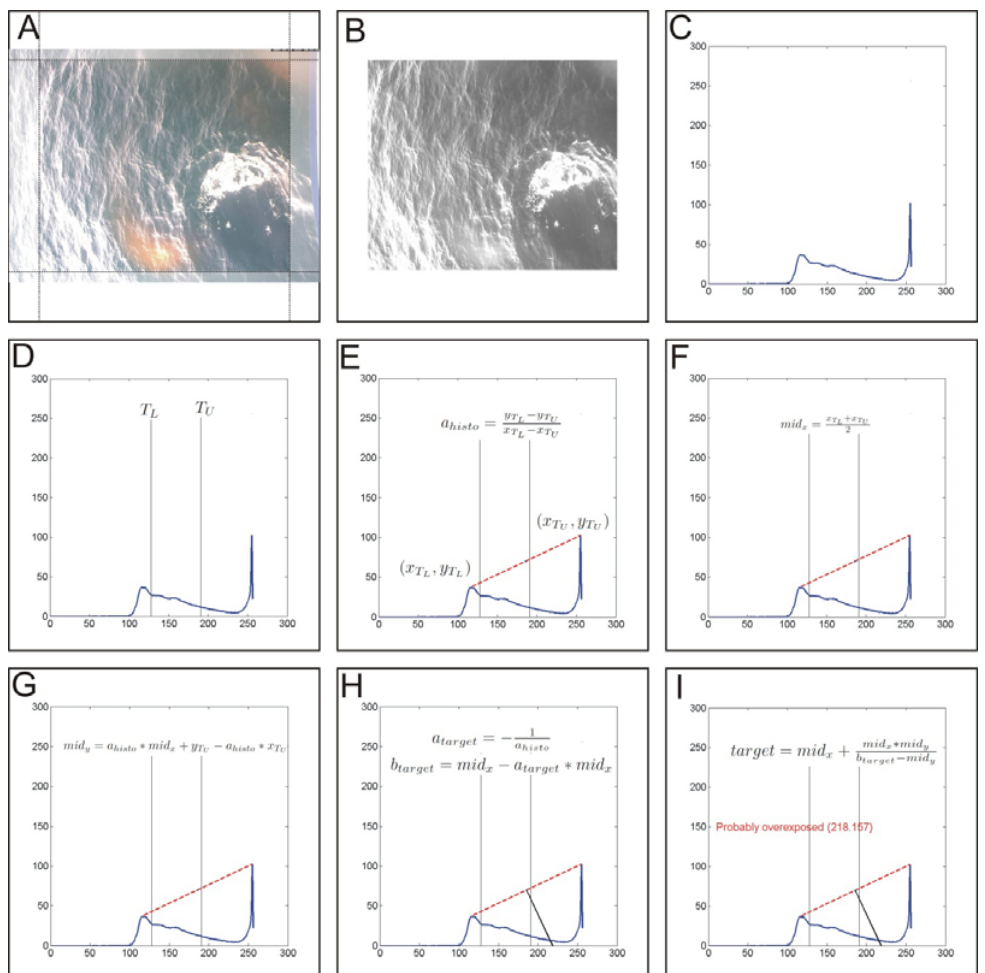
Figure 3. Schematic diagram of the automated sunglint image detection algorithm. ( A ) Cropping original sea surface image; ( B ) Converting cropped image to greyscale; ( C ) Extract grey level histogram of cropped and converted image; ( D ) Define lower (T ) L and upper (T ) threshold; ( E ) Find position and magnitude of local maxima of darker (x , y ) U TL TL and brighter (x , y ) colours and calculate slope of line segment; ( F – G ) Calculate TU TU midpoint (mid , mid ) of line segment between (x , y ) and (x , y ); ( H ) Calculate x y TL TL TU TU slope and intercept of the target line being perpendicular to the previously calculated slope , mid ); ( I ) Calculate target line’s crossing with abscissa. If line crossing the midpoint (mid x y and only if this value is larger than T , the image is tagged as probably U